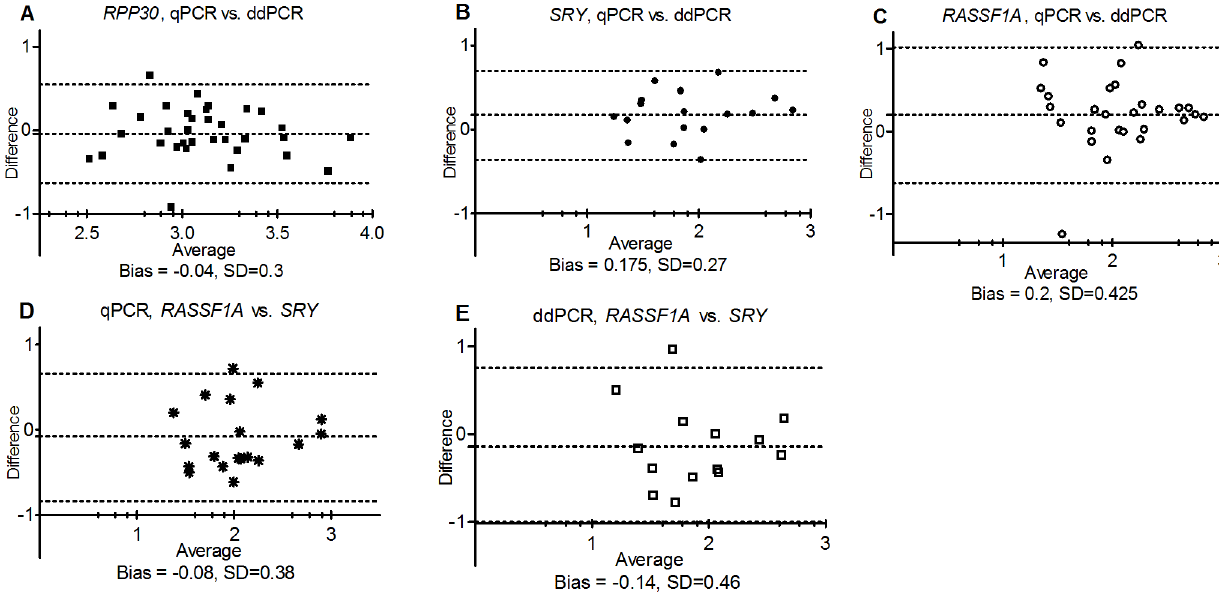
Figure 2. Difference (Bland–Altman) plots between two assays and two approaches. X-axis represents average value between two methods, Y-axis – difference between values, log 10 (GE/mL). Dotted lines indicate bias (mean difference) and 95% limits of agreement (2 SD) between the two given methods. A, B, C plots compare the results obtained with qPCR and ddPCR for RPP30, SRY and RASSF1A respectively; D, E compare the performance of SRY and RASSF1 assays for qPCR and